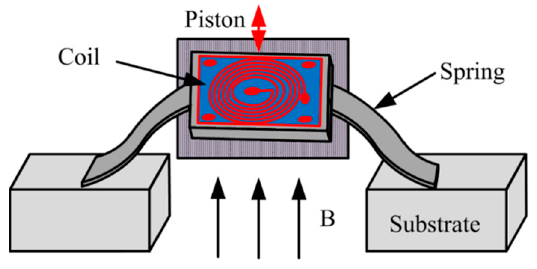
Figure 18. Coil-based magnetic actuators.